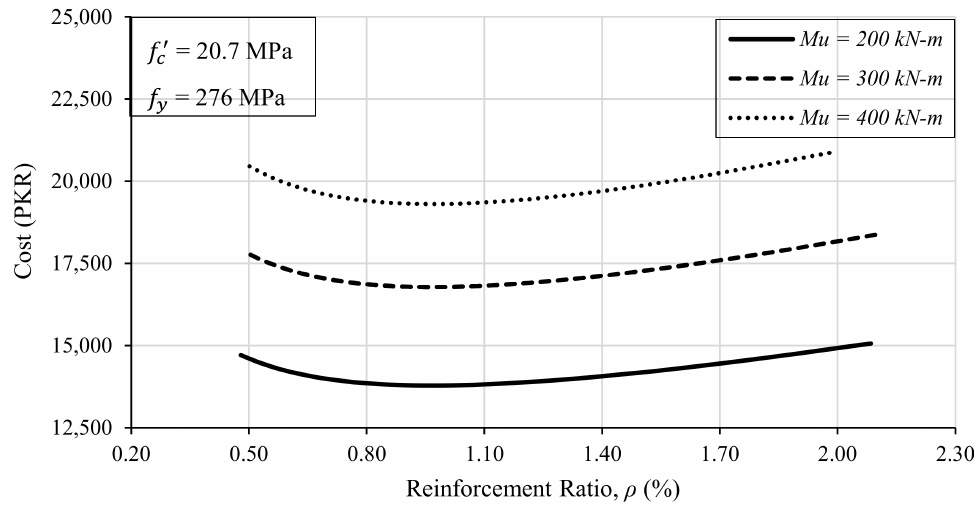
Figure 5. The effect of the reinforcement ratio ( ρ ) on the cost of the